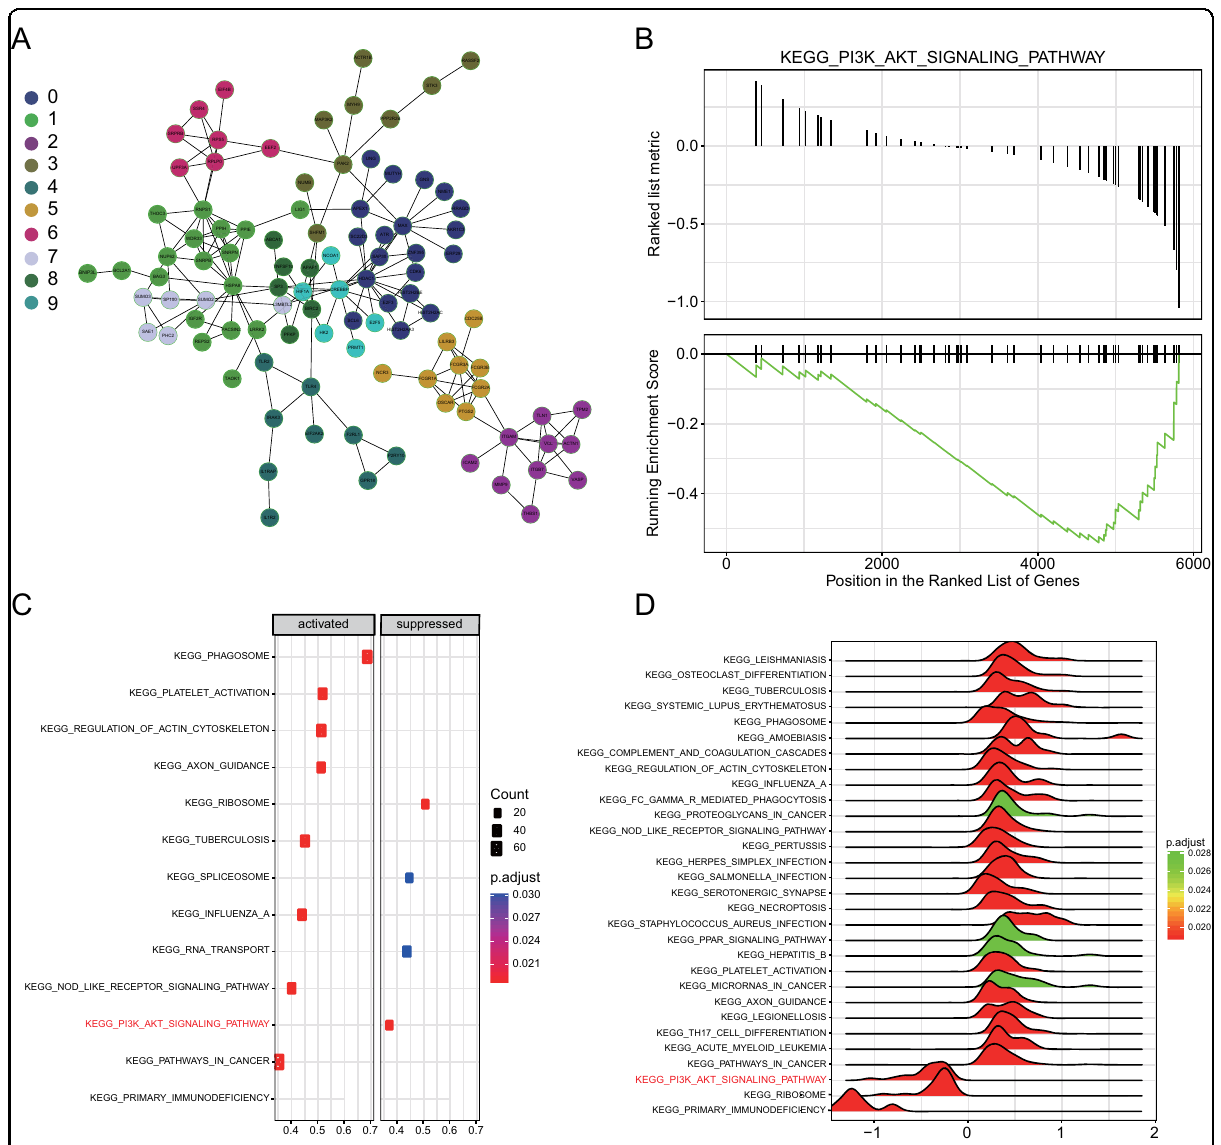
Fig. 2 The PI3K/Akt signaling pathway is inactivated during ischemic stroke. a Ten functional modules from the interaction network are presented, with different colors as indicated from 0 to 9. b The results of GSEA indicates that the PI3K/Akt signaling pathway is inactivated during ischemic stroke. c The results presented as a dotplot show that the PI3K/Akt signaling pathway is downregulated during ischemic stroke. d The results presented as a joyplot show that the PI3K/Akt signaling pathway is downregulated during ischemic